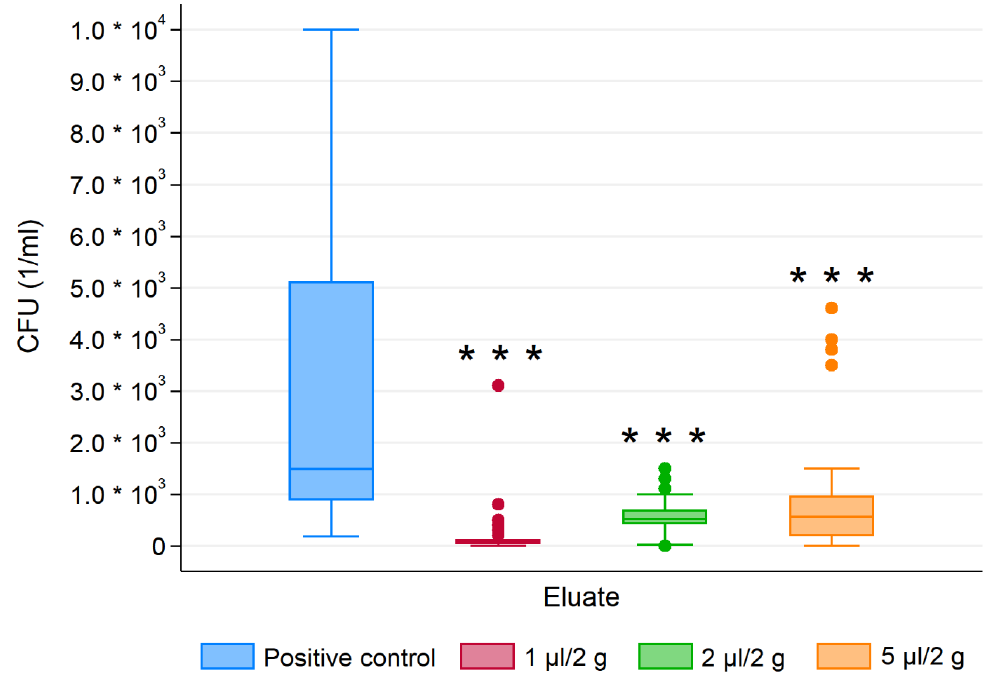
Figure 6. Colony forming units (CFU) of L. acidophilus for essential oil modified composite resins and the control group. *** p < 0.001 versus control.